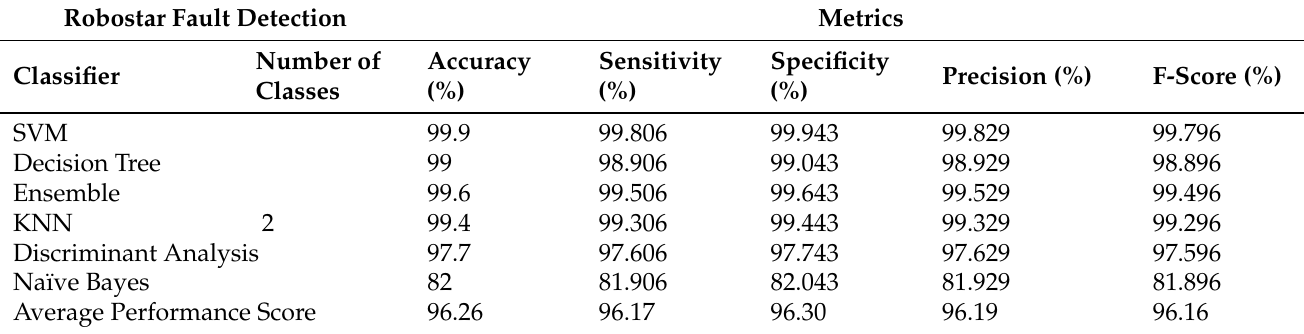
Table 1. Classifiers performance score for Robostar fault